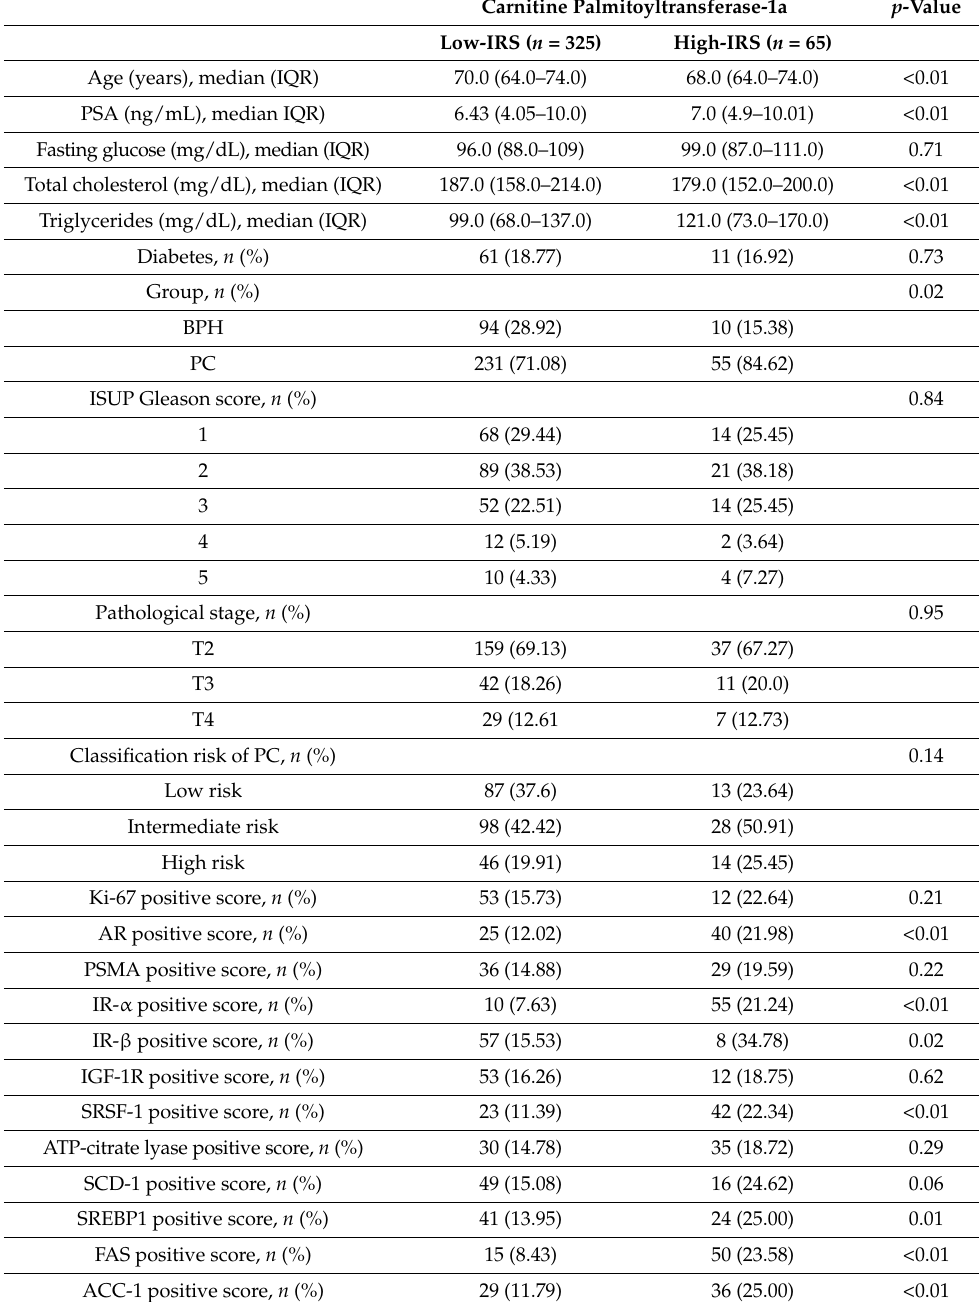
Table 2. Carnitine palmitoyltransferase-1a expression according to IHC